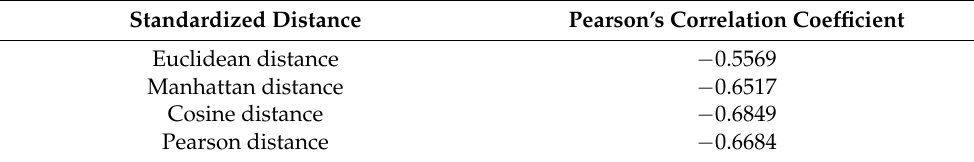
Figure 3. Sharpe ratio and histogram for each distance. ( a ) scatter plots of each distance and the Sharpe ratio; ( b ) histograms of the distance. Table 3. The correlations between each distance and the Sharpe ratio.